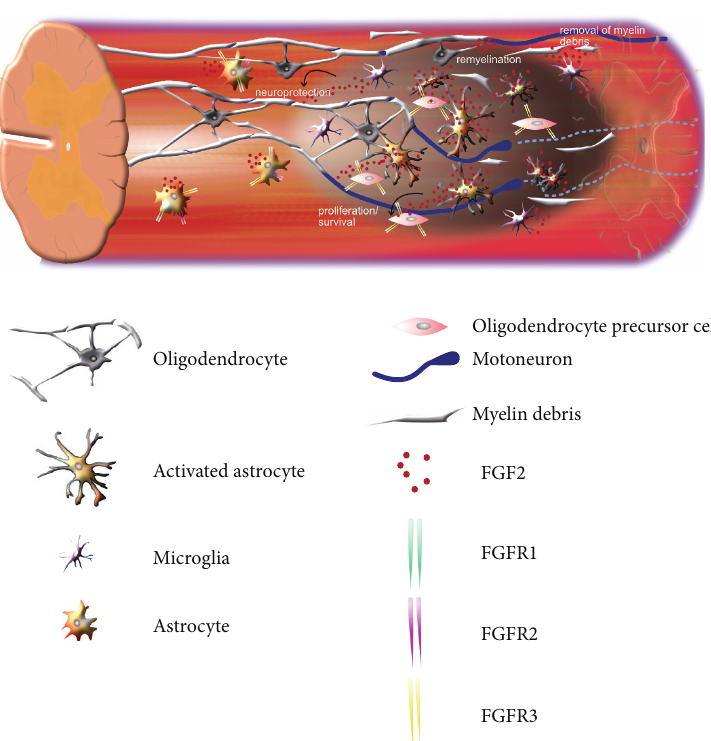
Figure 2: Overview of the spinal cord lesion and cells found in the lesion with their action stimulated by FGFR